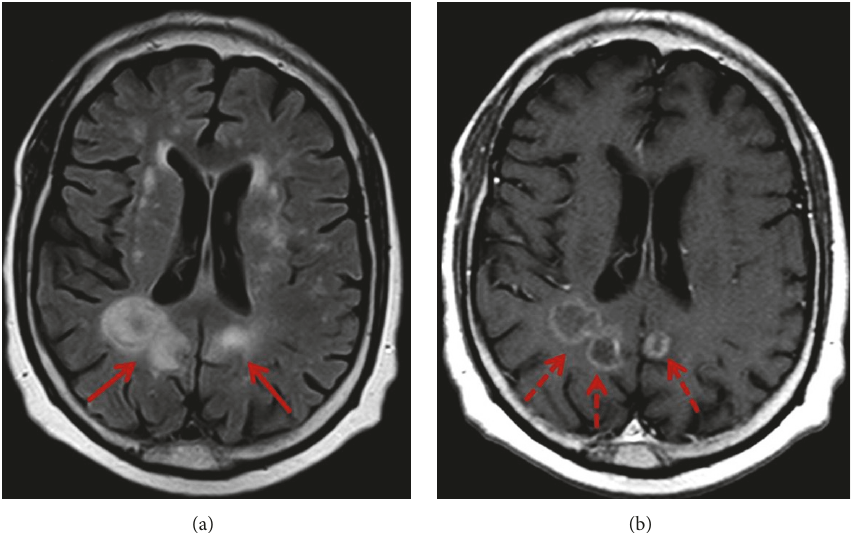
Figure 4: Axial T2-weighted FLAIR (a) and T1-weighted postcontrast MR images (b) demonstrate ring enhancing lesions in the bilateral parietal lobes (dashed arrows) at the level of the basal ganglia with surrounding vasogenic edema (solid arrows) in keeping with brain